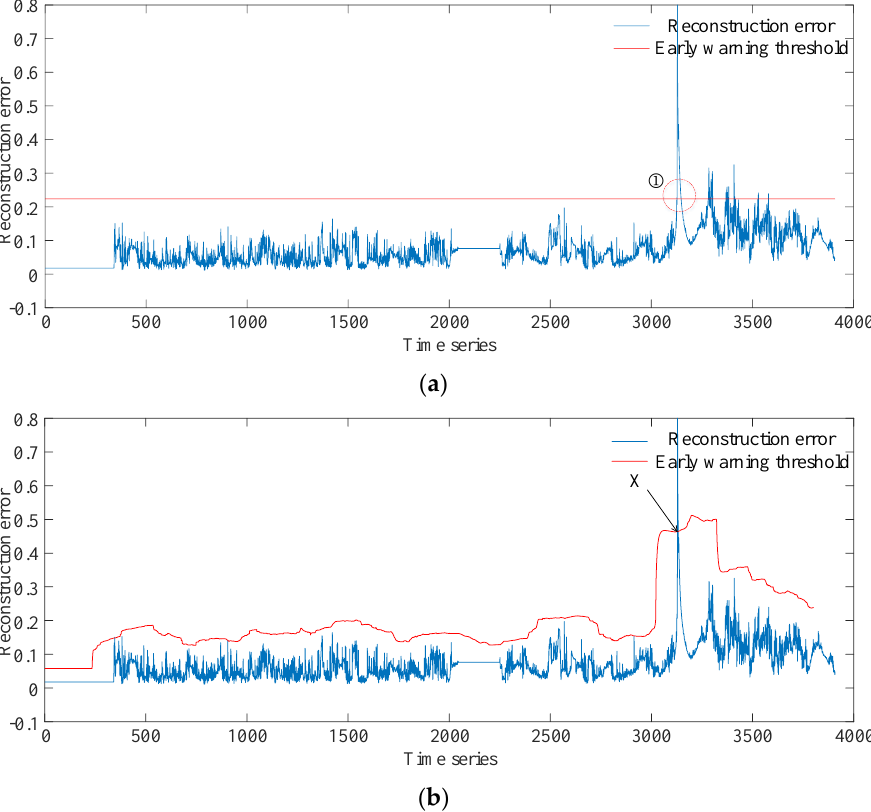
Figure 8. Validation set reconstruction error. ( a ) Variation trend of residual wind speed. ( b ) Change trend of power residual.